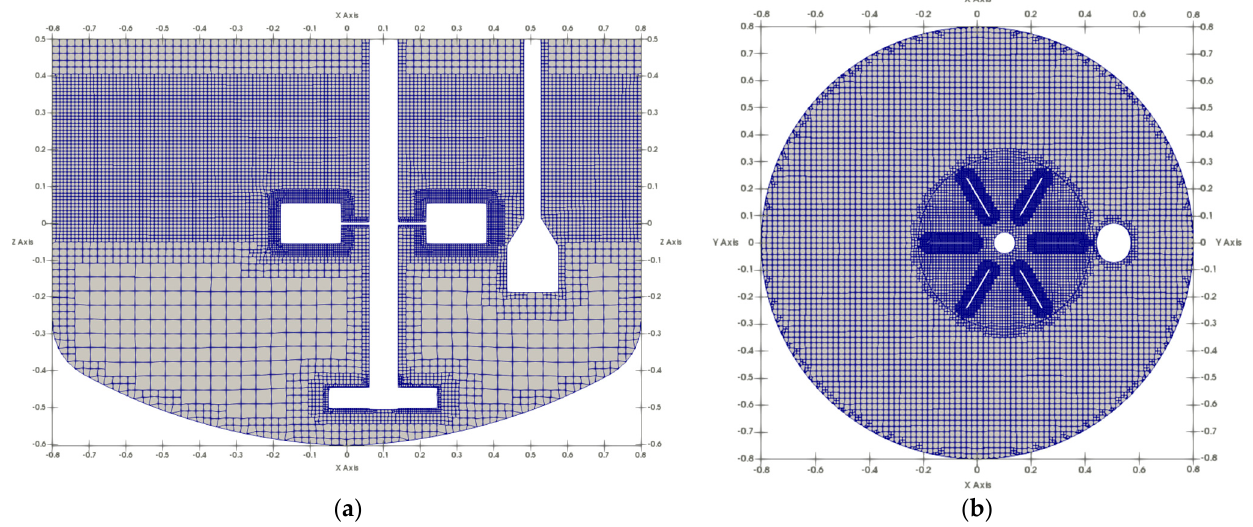
Figure 3. Cross − sectional views of the side ( a ) and top ( b ) at Y = 0 and Z = 0.